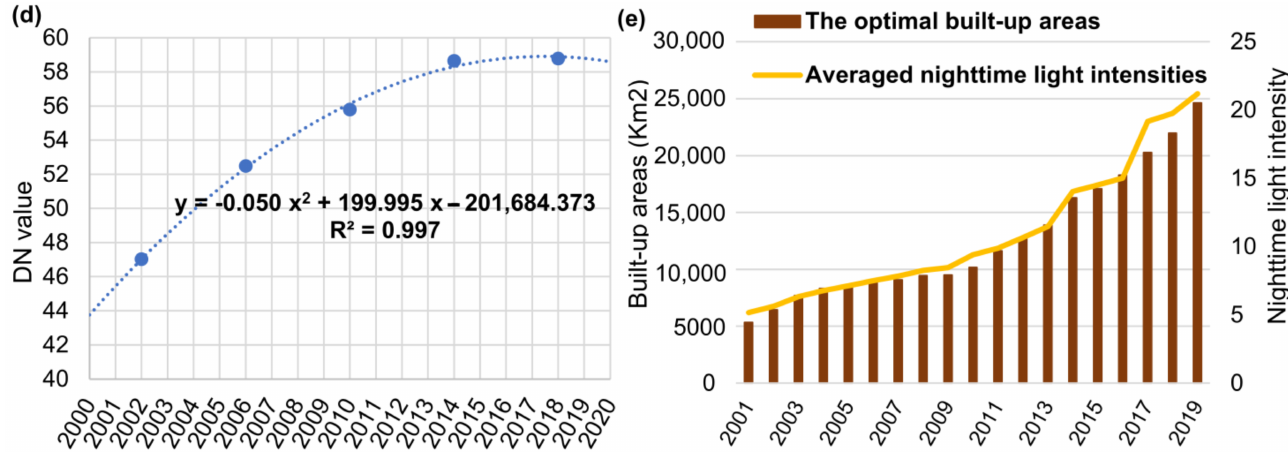
Figure 3. Geographical settings of ( a1 – a5 ) reference built-up areas from Landsat images, ( b1 – b5 ) corresponding nighttime light based optimal built-up areas, and ( c1 – c5 ) built-up areas extracted by the same nighttime light threshold over Yangtze River Delta. The optimum nighttime light threshold was determined according to ( d ) the non-linear fit of the threshold values (DN) in 2002, 2006, 2010, 2014, and 2018, within which built-up areas from the nighttime light data were most similar to the reference data in terms of the spatial area. Finally, ( e ) annual statistics of the built-up areas and averaged nighttime light intensities over the Yangtze River Delta (calculated for